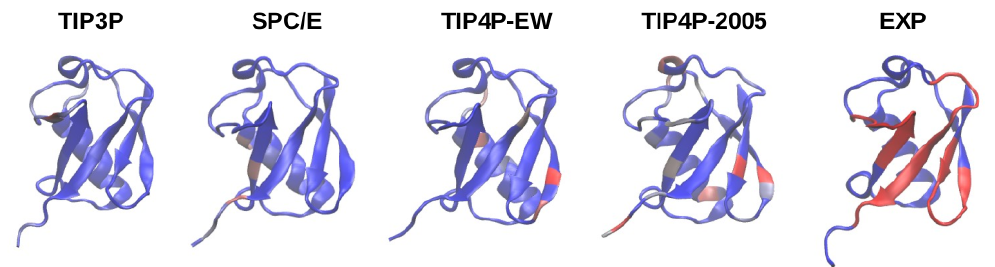
Figure 2. Intermolecular contact frequency along the sequence of the ubiquitin molecule, obtained using TIP3P, TIP4P/2005, SPC/E and TIP4P-EW, using a color scale from blue (zero contacts) to red. At right we show the experimental interface (highlighted in red) for